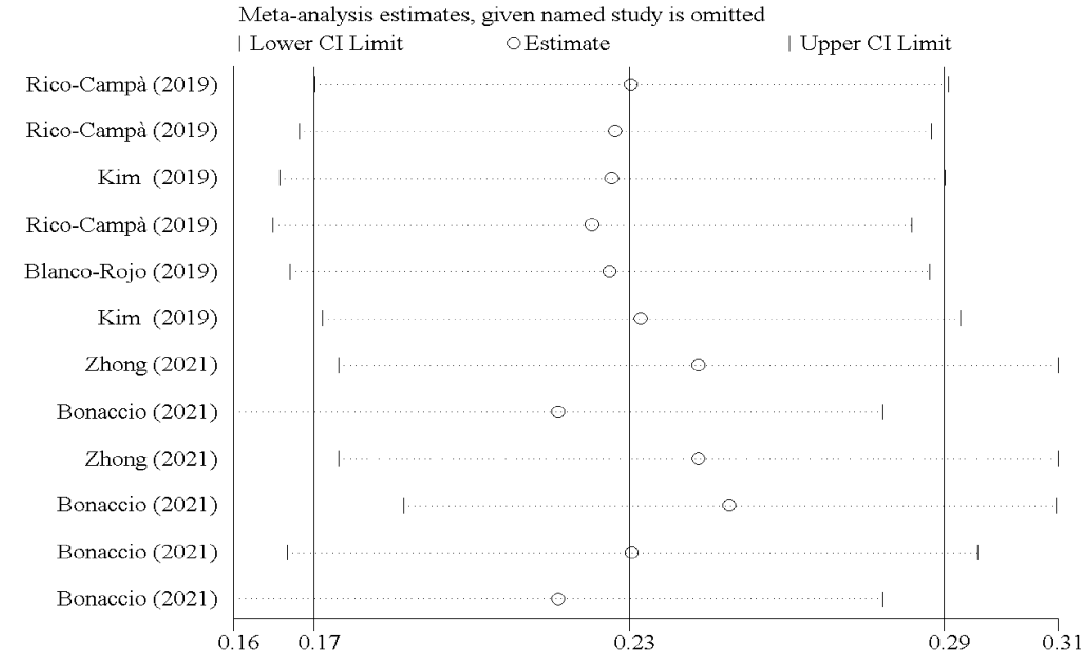
Figure 5. Forest plots showing sensitivity analysis results.